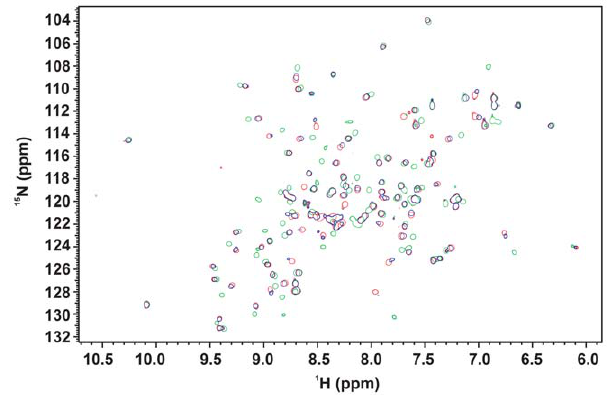
Figure 5. Testing competition of Atx1_pS_ULM_PE binding to 14-3-3 f and U2AF65_UHM. 15 N labeled U2AF65_UHM saturated with unlabelled Atx1_pS_ULM_PE was titrated with unlabelled 14-3-3 f . The HSQC spectra of U2AF65 UHM in its free form (red), saturated with a 2 fold molar excess of Atx1_pS_ULM_PE (green) and saturated with a 1:1 14-3-3 f /Atx1_pS_ULM_PE mixture in a 2 fold molar excess to U2AF65 UHM (blue) are compared.